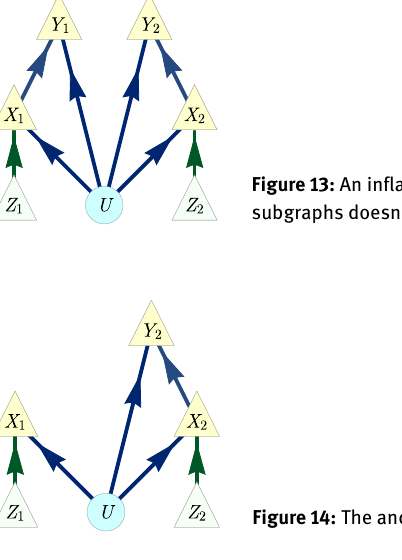
Figure 14: The ancestral subgraph of Fig.13 for either { X 1 Y 2 Z 1 } or { X 1 Y 2 Z 2 }